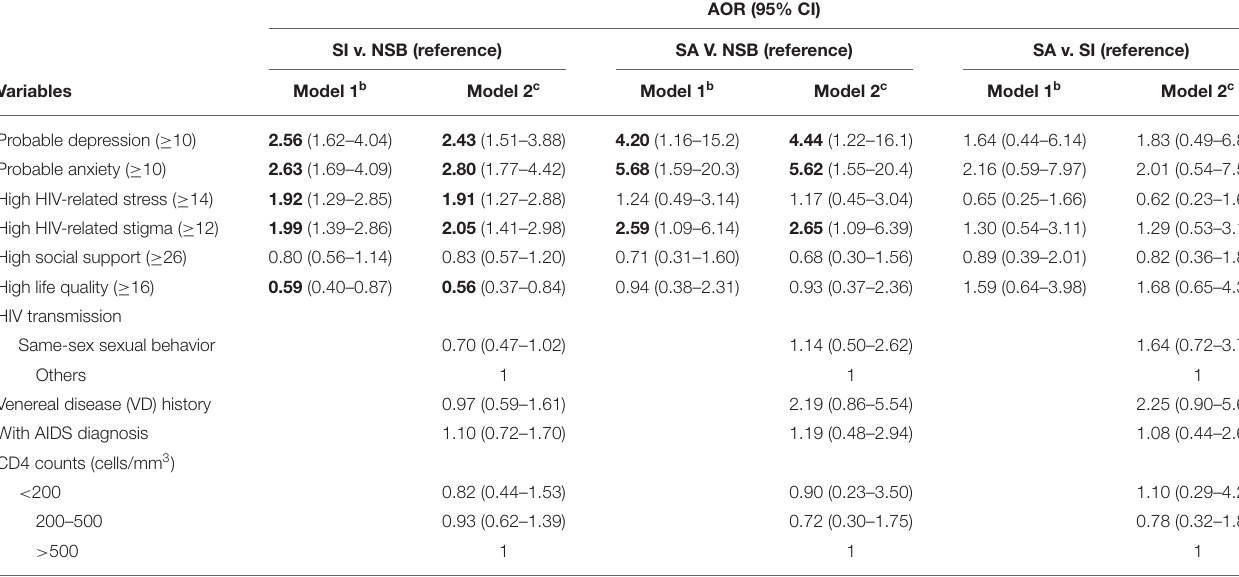
TABLE 4 | Adjusted odds ratios (AORs) and 95% Confidence Intervals (95% CIs) of factors associated with SI or SA among PLWH using multinomial logistic regression a